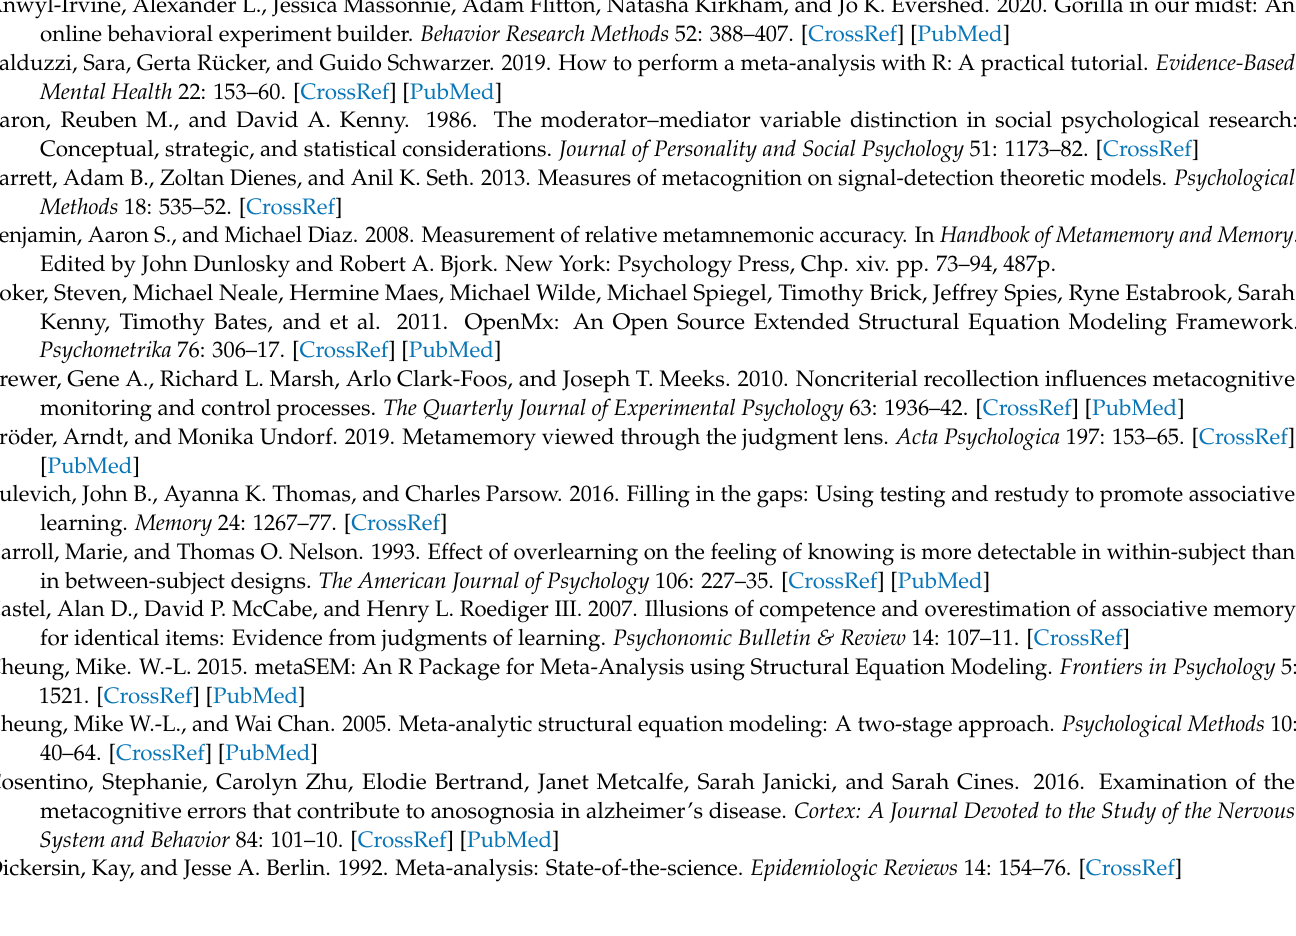
equivalent to Yule’s Q and is no longer consistent with signal-detection